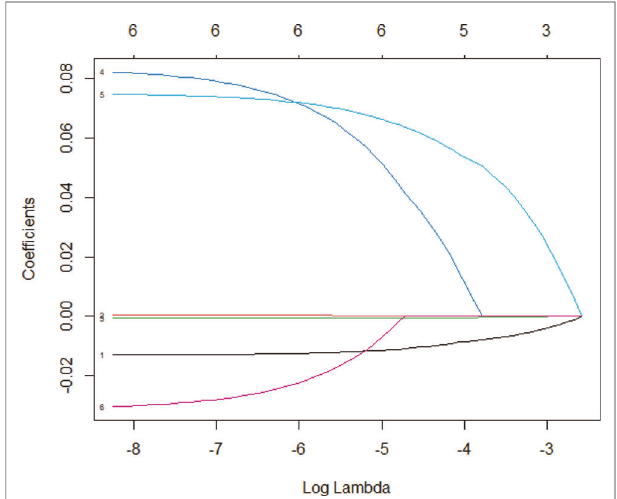
FIGURE 4 | Lasso regression of the included predictors for recurrence after conservative surgery of intestinal deep endometriosis. 1, age; 4, infection; 5, Enzian; 6, surgery